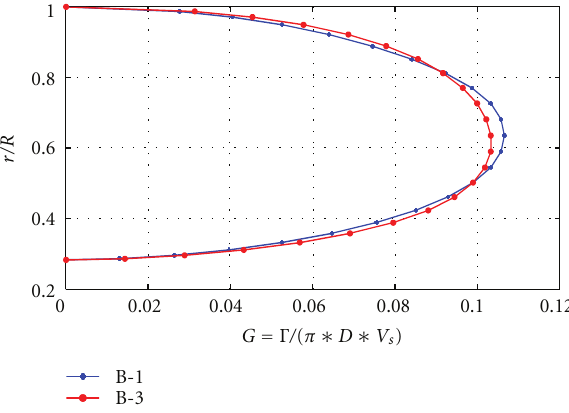
Figure 24: Camber/chord length, aft propeller.